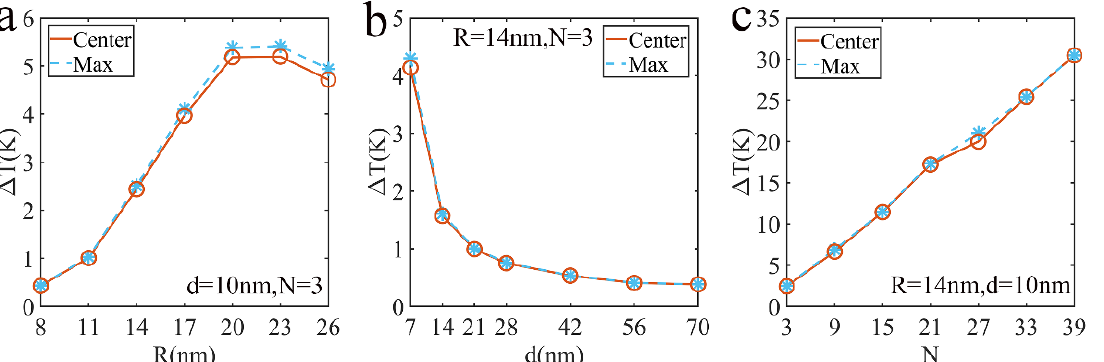
Figure 12. The central and maximum temperature of Ag nanoparticle array structure: ( a ) radius dependent, ( b ) particle spacing dependent, ( c ) particle number dependent.